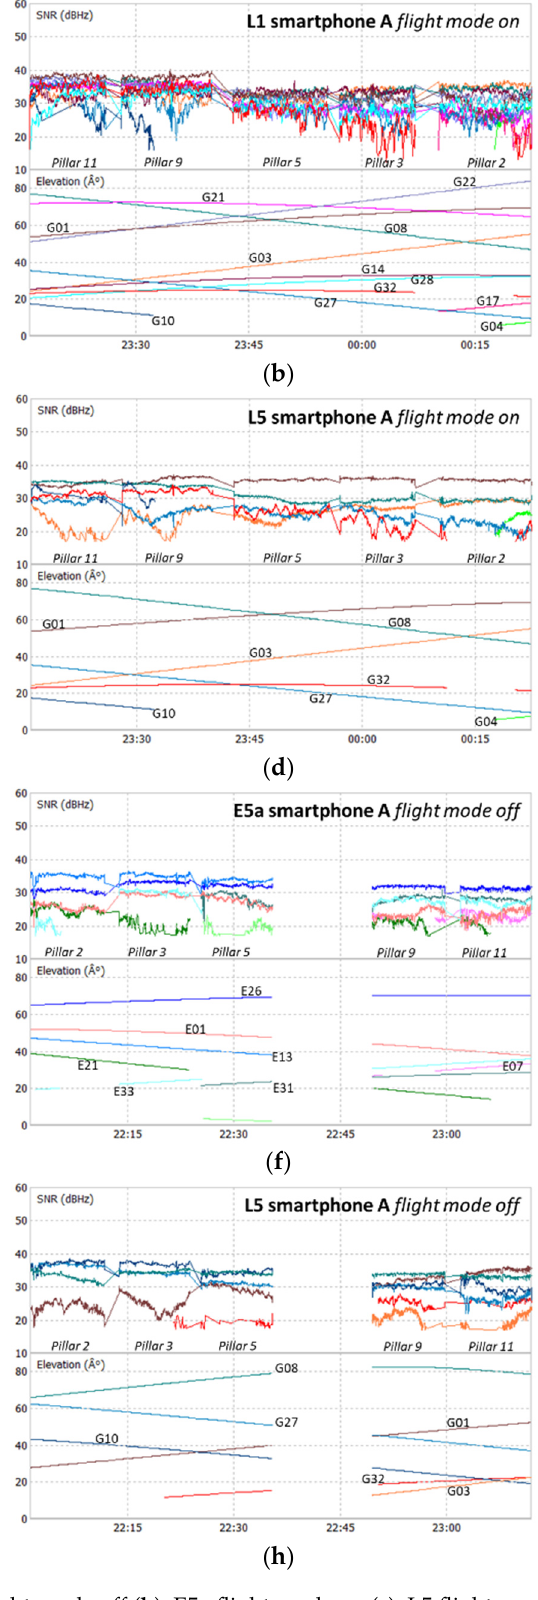
Figure 6. Test 1 SNR smartphone A: E1 flight mode on ( a ); L1 flight mode off ( b ); E5a flight mode on ( c ); L5 flight mode on ( d ); E1 flight mode off ( e ); L1 flight mode off ( f ); E5a flight mode off ( g ); L5 flight mode off ( h ).